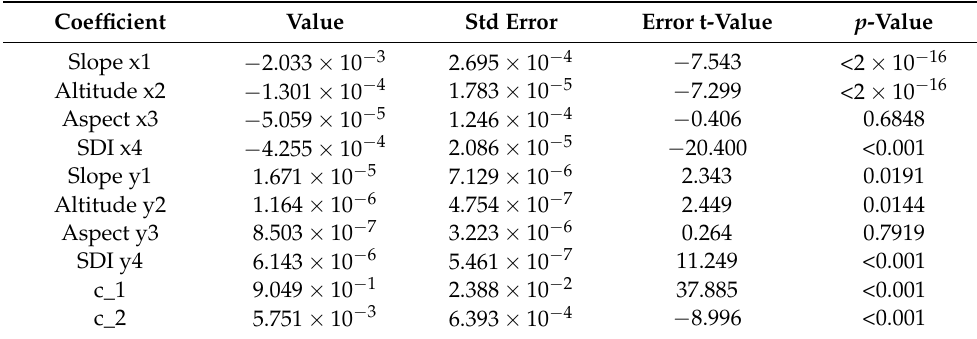
Table 2. Coefficient of the LM. RMSE = 0.2207 cm/year on 8621 degrees of freedom.